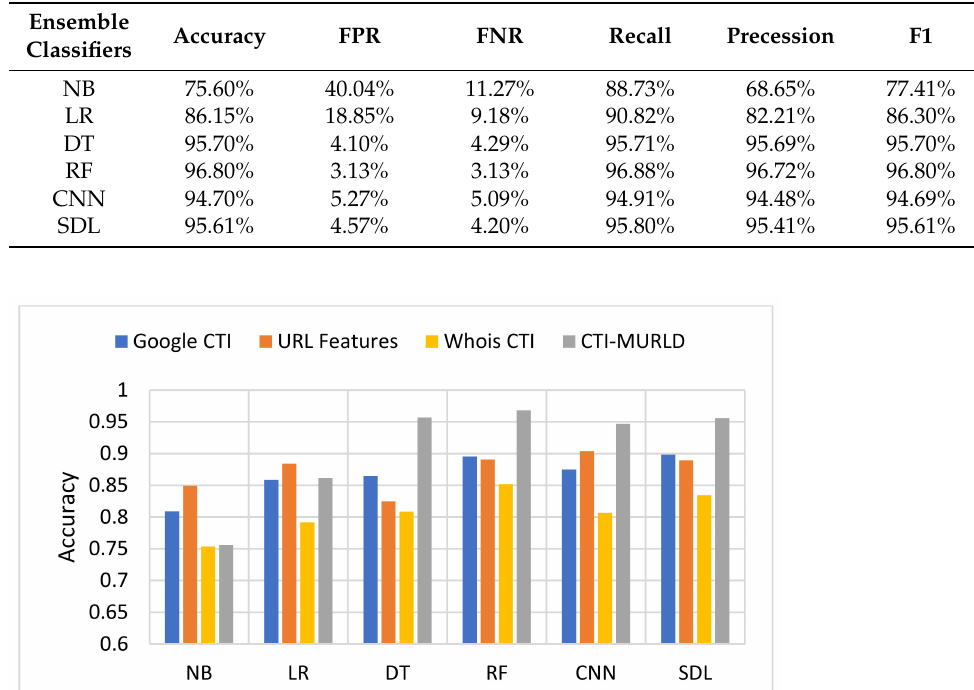
Table 2. Performance of the CTI-MURLD model using Different Classifiers.